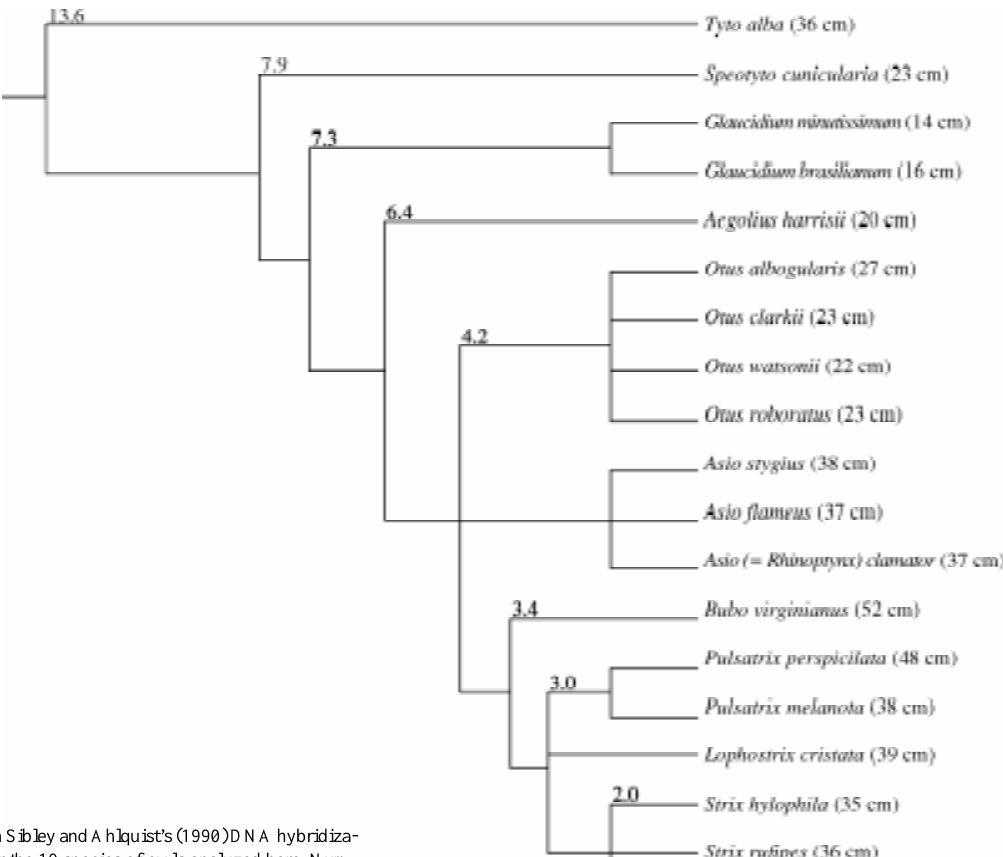
Figure 1 - Phylogeny based on Sibley and Ahlquist’s (1990) DNA hybridiza- tion data and body lengths for the 19 species of owls analyzed here. Num- bers indicate genetic distances, that can be converted into time (millions of years) by multiplying values by